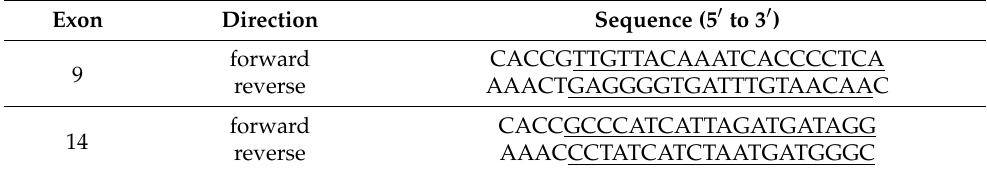
Table 2. Oligonucleotides used for expression of sgRNA sequences targeting BRCA1. Target sequence is